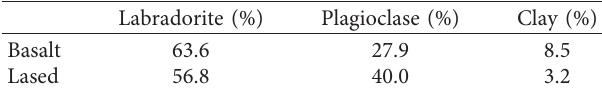
Figure 2: Surface morphologies of basalt by fiber laser irradiation. (a) Full view of laser perforation. (b) Nonirradiated surface. (c) Holes and vacuoles in the glazed layer. (d) Cracks on the edge of perforation. Table 4: Compositions of basalt before and after laser